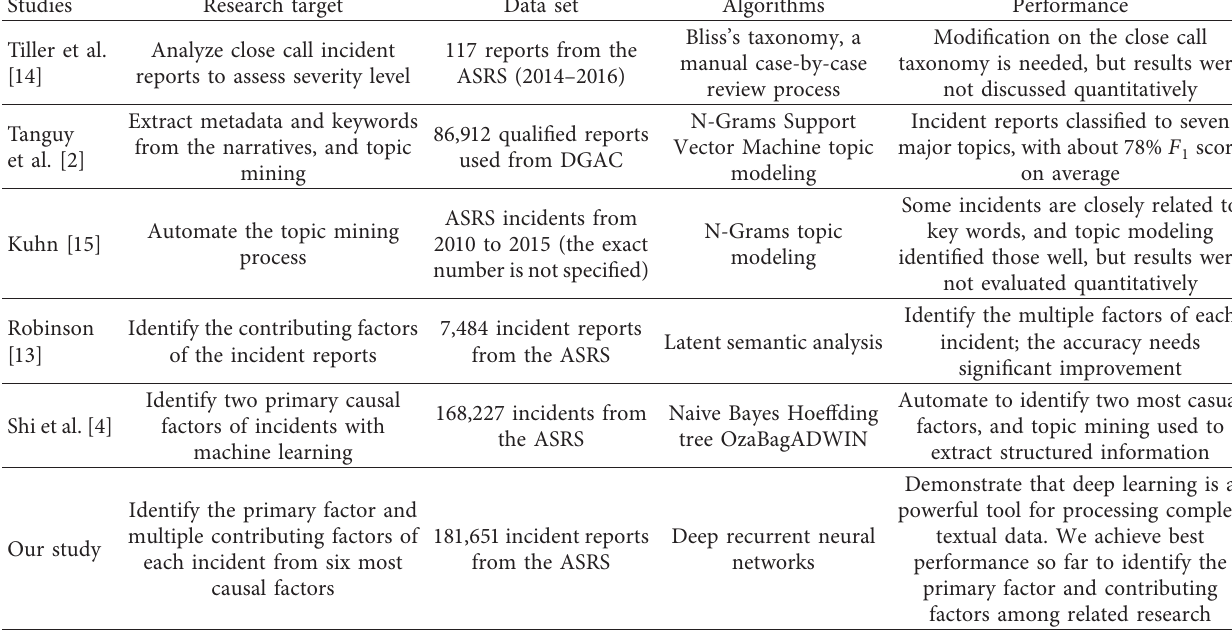
Table 2: A comparison of our study with extant research related to aviation reporting